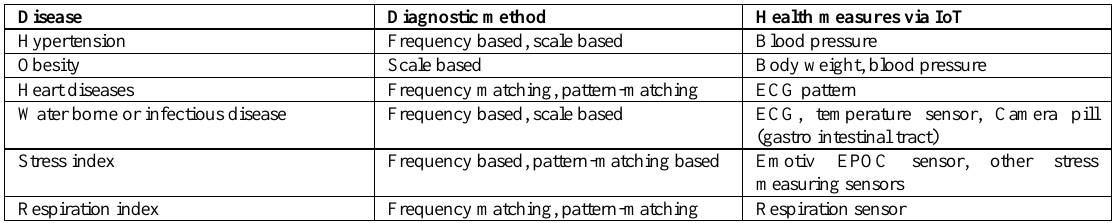
Table 1. A scheme for diseases diagnosis in a